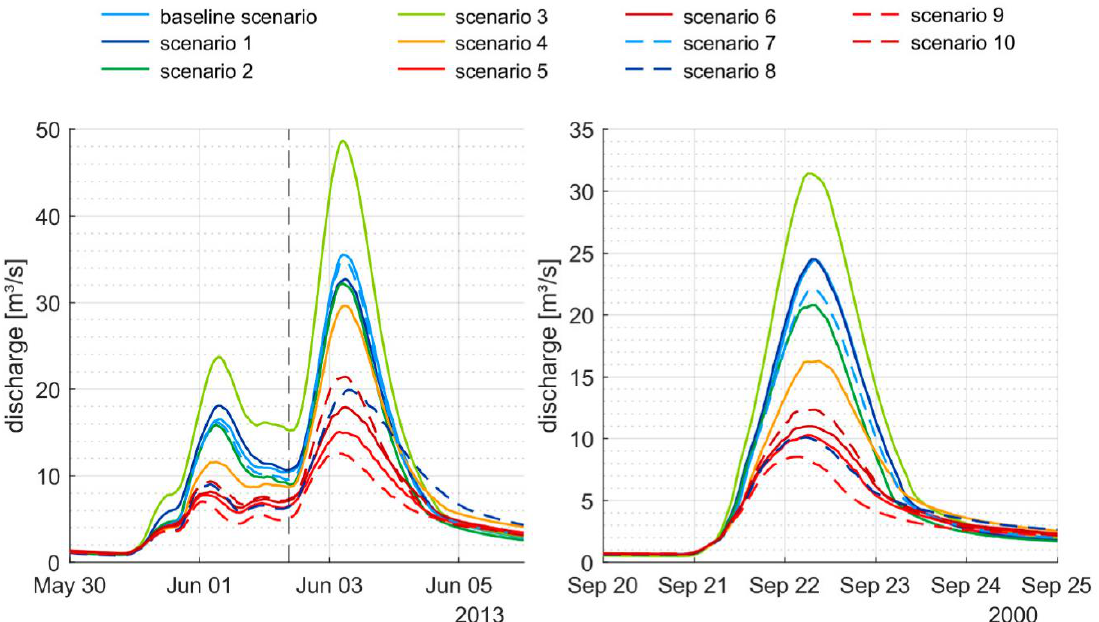
Figure 4. Hydrographs of the baseline scenario and the 10 scenario runs for two exemplary events (scenario description: Table 3). Table 5. Peak changes (%) and volume changes (%) of the selected events in Figure 4 and the calibration and validation periods the event in June 2013 is evaluated separately for both peaks.